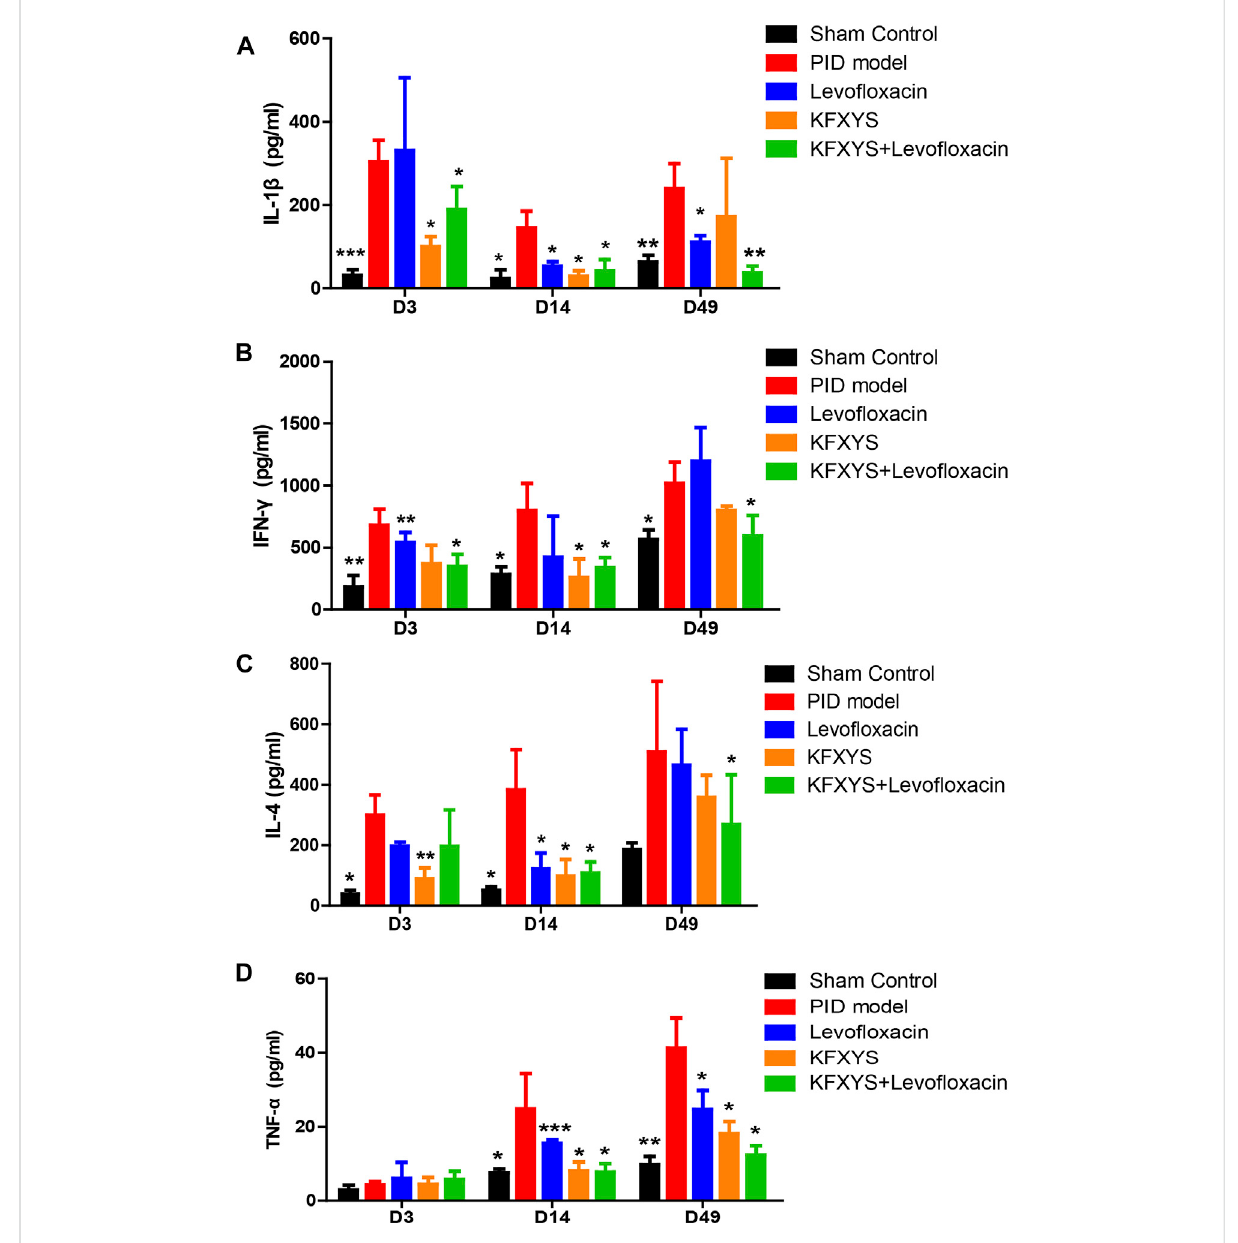
FIGURE 3 Decreasing effect of different drugs on the blood levels of the immune-related factors IL-1 β , IFN- γ , IL-4, and TNF- α in rats. Expression changes are presented as the mean ± SD ( n = 4). The data were analyzed using one-way ANOVA and unpaired t test. * p < 0.05 vs the PID